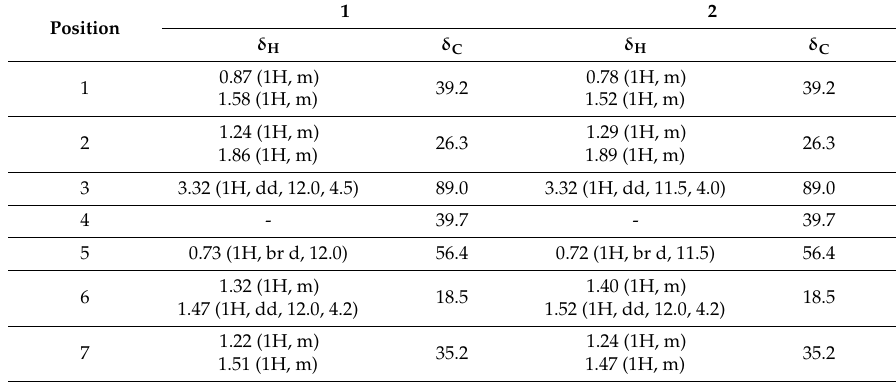
Table 1. 1 H- and 13 C-NMR data for 1 and 2 (500 and 125 MHz, C 5 D 5 N, J in Hertz, and δ in ppm).